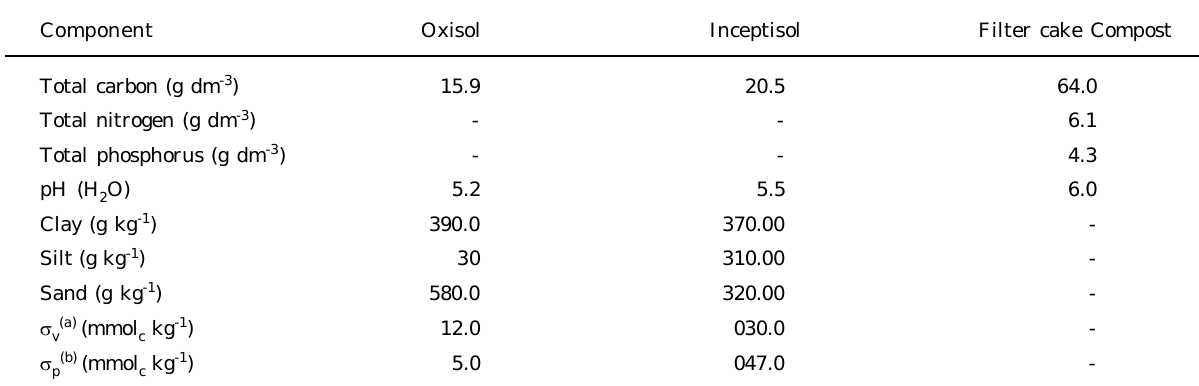
Table 1. Particle-size distribution, electrochemical and chemical properties of the soils and filter cake compost